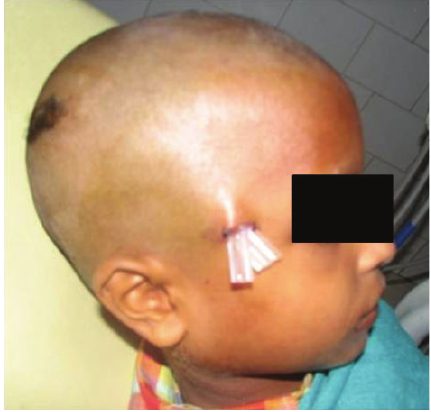
Figure 3: Postoperative picture after the second surgical interven- tion.